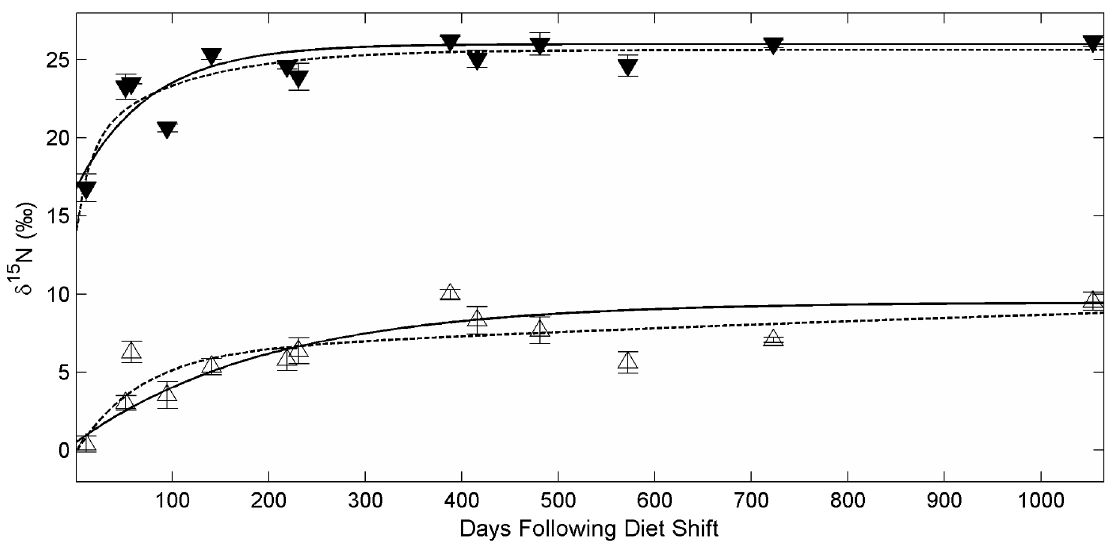
Figure 4. Multi-compartment exponential fit model of amino acid isotopic composition of Pacific bluefin tuna ( Thunnusorientalis ). Changes of d 15 N values of proline (filled inverted triangle), a trophic amino acid, and serine (unfilled triangle), a source amino acid in white muscle tissue of Pacific bluefin tuna as a function of time. Solid lines represent the single compartment exponential fit model and dashed lines include a second compartment within the model as described by Cerling et al. (2006).